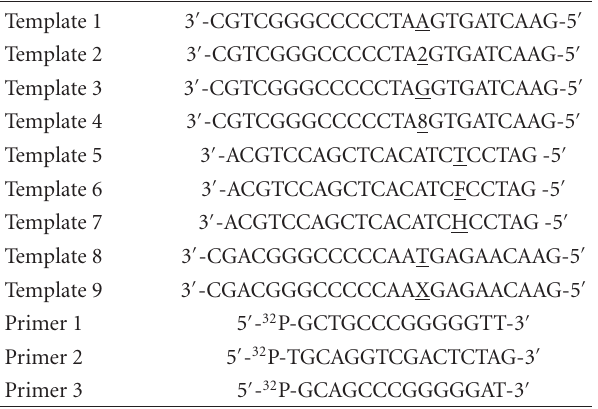
Table 1: Nucleotide sequences of oligonucleotides used in this